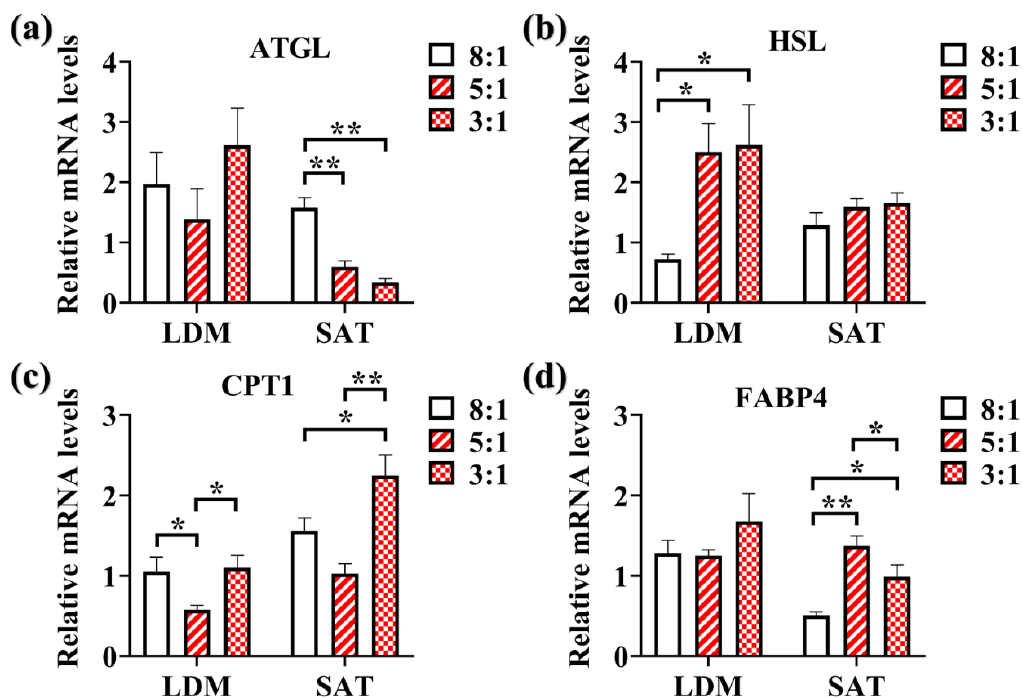
Figure 2. The expression of relative genes in longissimus dorsi muscle (LDM) and subcutaneous adipose tissue (SAT) from Heigai pigs fed with di ff erent diets. The influences of di ff erent n-6 / n-3 polyunsaturated fatty acids (PUFA) ratio on adipose triglyceride lipase (ATGL) ( a ), hormone-sensitive lipase (HSL) ( b ), carnitine palmitoyltransferase 1 (CPT1) ( c ), and fatty acid binding protein 4 (FABP4) ( d ) expression in LDM and SAT of Heigai pig. ‘8:1, 5:1, 3:1’: di ff erent n-6 / n-3 PUFA ratio diets. Results were presented by mean ± standard error of the mean (SEM) ( n = 4, number of replicates). ‘*’ p < 0.05; ‘**’ p < 0.01.